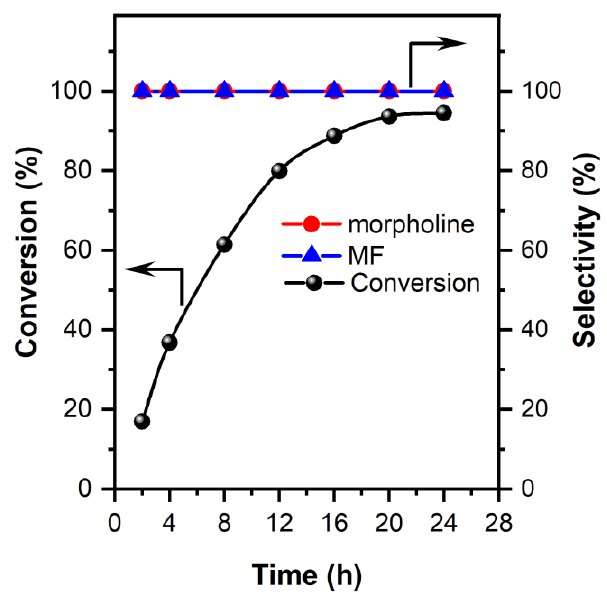
Figure 5. The effect of reaction time on the conversion of NFM and product selectivities. Reaction conditions: 0.3 g 13.5% CaO/MgO, 1.0 mmol NFM, 120 °C, 15 mL methanol.